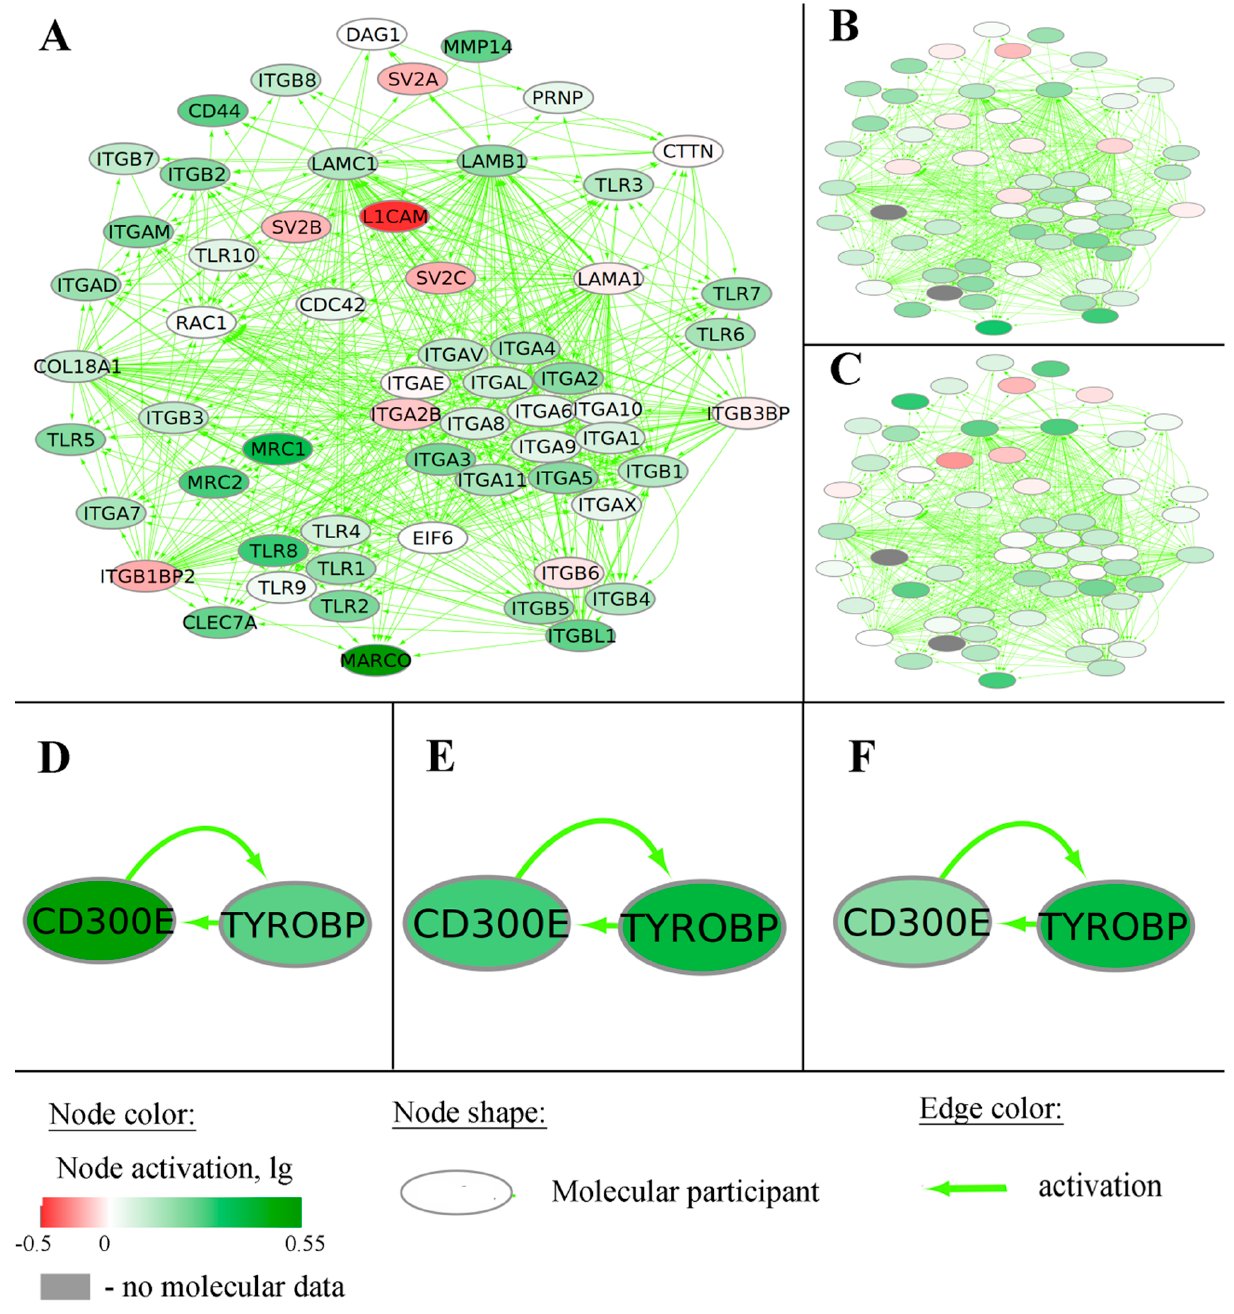
Figure 12. Pathway activation charts for marker pathways in mesenchymal vs. proneural GBM molecular subtypes. LAMB1-centric pathway: TCGA ( A ), CGGA_325 ( B ), and CGGA_693 ( C ) expression datasets. Nodes on panel A correspond to nodes on panels B and C. CD300E-centric pathway, TCGA ( D ), CGGA_325 ( E ), CGGA_693 ( F ) expression datasets. Node activation was calculated as a logarithmic ratio of geometric mean of expression levels in the GBM subgroups under